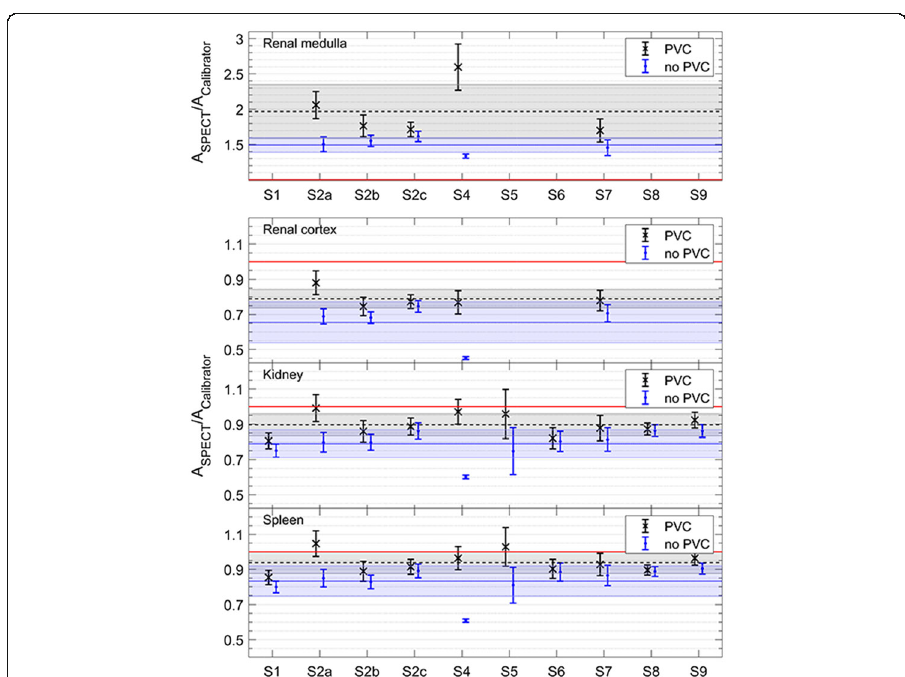
Fig. 6 Activity ratios with (black cross) and without (blue circle) PVC applied for renal medulla, renal cortex, kidney and spleen inserts (top to bottom). For each case, the horizontal line shows the average ratio across all setups with the shaded area showing the region within one standard deviation, whilst the red line represents 100% accuracy. Note the different vertical scale for the renal medulla